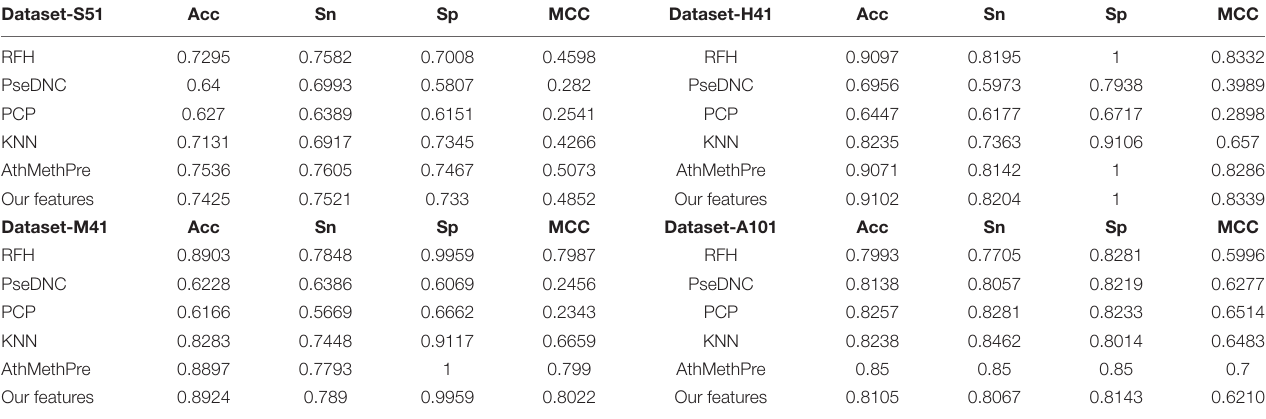
TABLE 4 | Comparison with other feature representation algorithms.